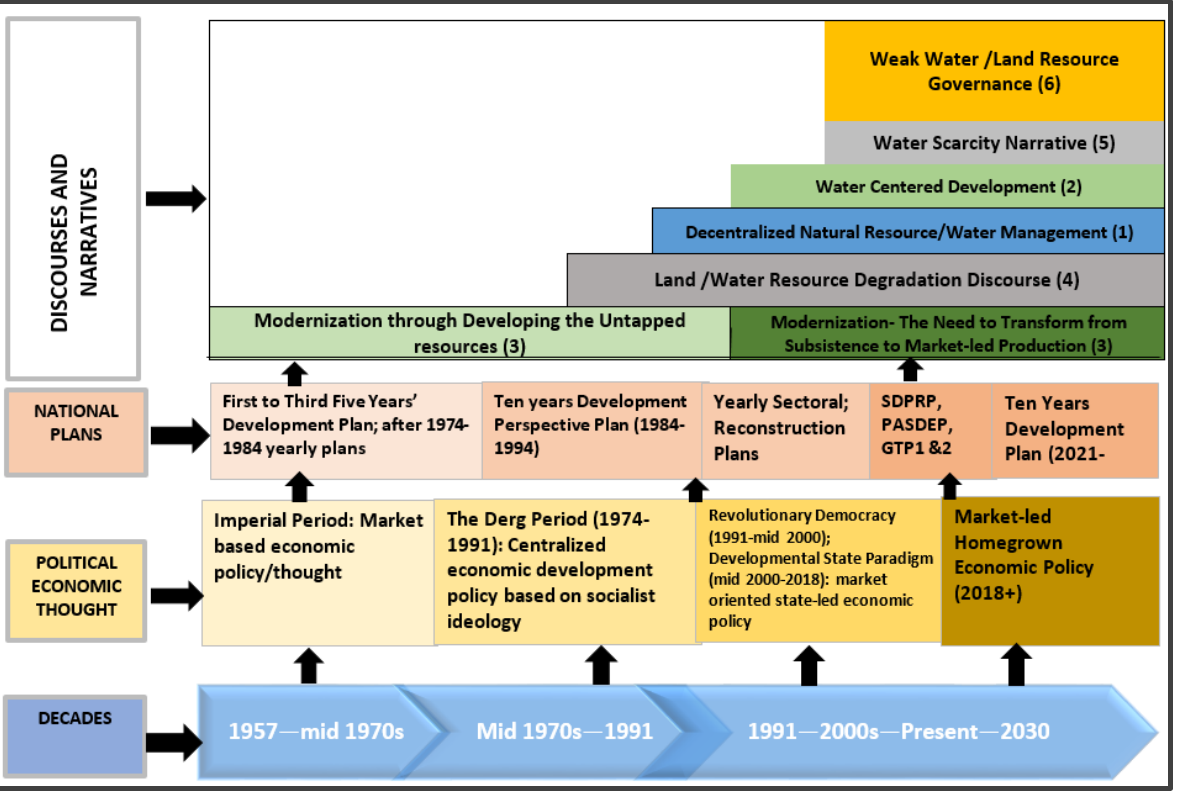
Figure 2. A sketch showing a timeline of water resource management discourses and narratives in Ethiopia, which are shaped by different political and economic systems of the period. Note: NR—Natural Resource; SDPRP—The Sustainable Development and Poverty Reduction Program (2002/03–2004/05); PASADEP—Plan for Accelerated and Sustained Development to End Poverty (2005/06–2009/10); GTP 1—Growth and Transformation Plan 1 (2010/11–2015/16); and GTP 2— Growth and Transformation Plan 2 (2015/16–2019/20). The color is to show the different discourses and their emphasis over time. The numbers in the bracket indicate the major discourses discussed in the preceding